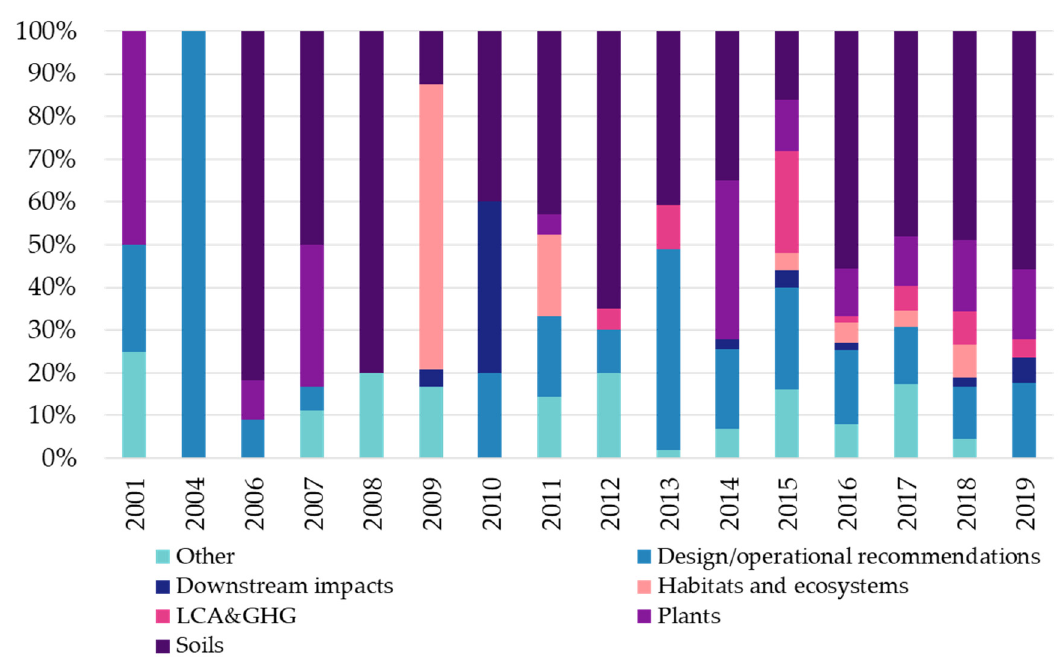
Figure 13. Breakdown of “other” topics covered in bioretention research, by year.